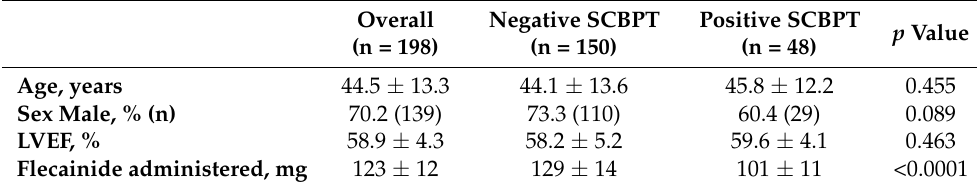
Table 2. Comparison of baseline clinical characteristics of the test cohort based on Brugada syndrome diagnosis after Sodium Channel Blocker Provocation